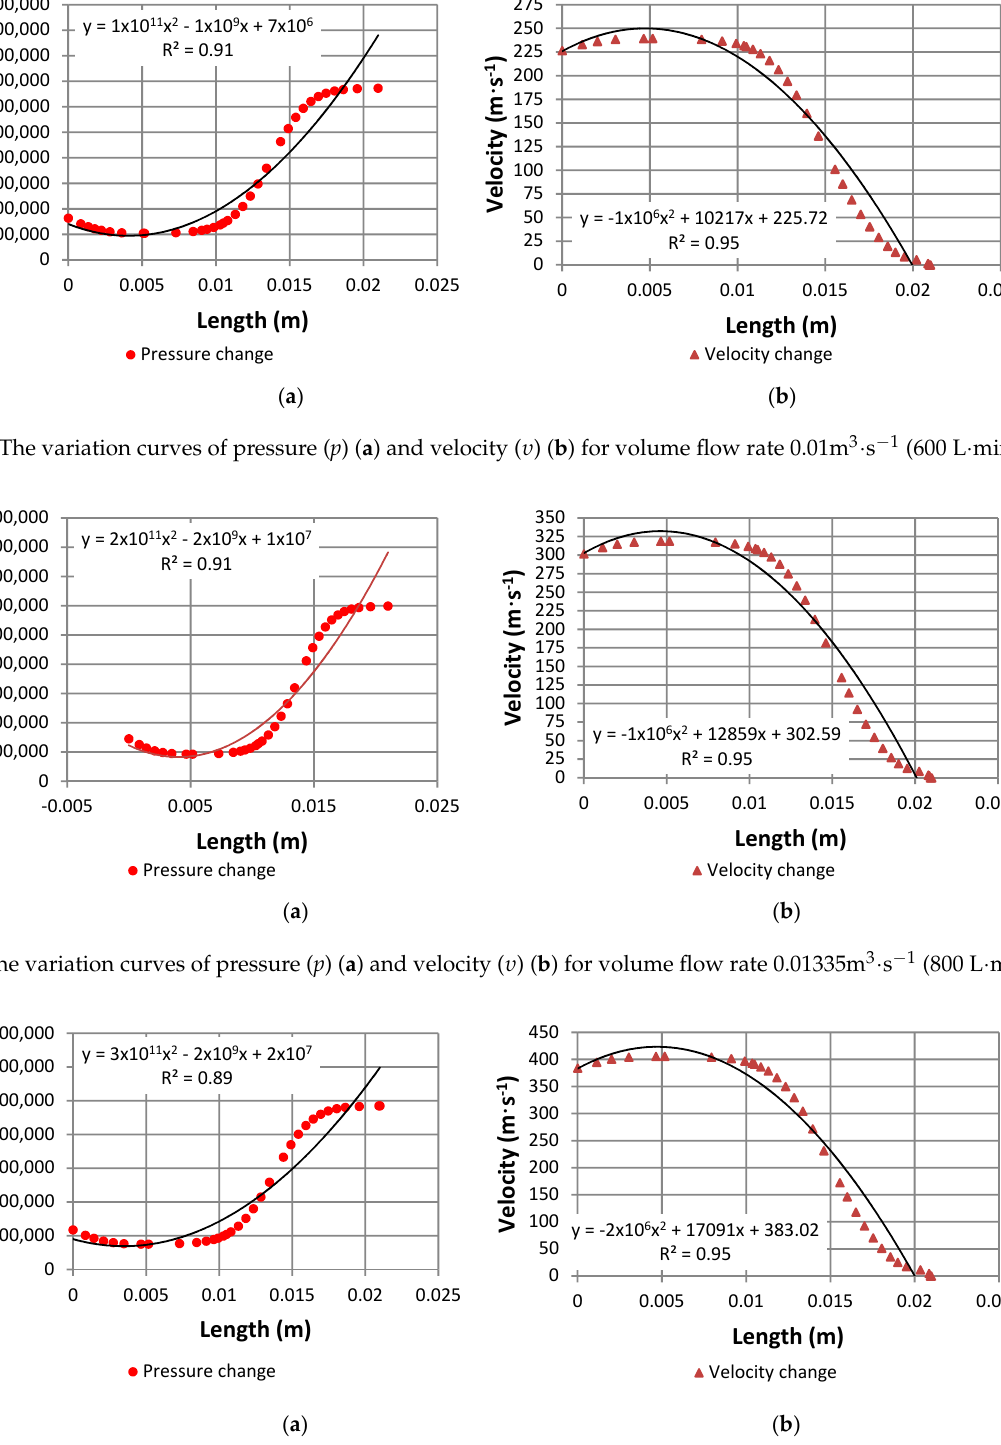
Figure 15. The variation curves of pressure ( p ) ( a ) and velocity ( υ ) ( b ) for volume flow rate 0.017 m 3 · s − 1 (1020 L · min − 1 ). The pressure-length curve in Figure 11a shows that pressure changes in a range from approx. 1 × 10 6 Pa, at the slide-piston inlet, to approx. 4 × 10 6 Pa, at the slide-piston outlet, for a volume fluid flow which equals 0.0033 m 3 s − 1 . In the case of the results in Figure 11b, the velocity-length curve shows that the velocity is 70 m · s − 1 at the slide-piston outlet but the velocity at the outlet is 0.02 m · s − 1